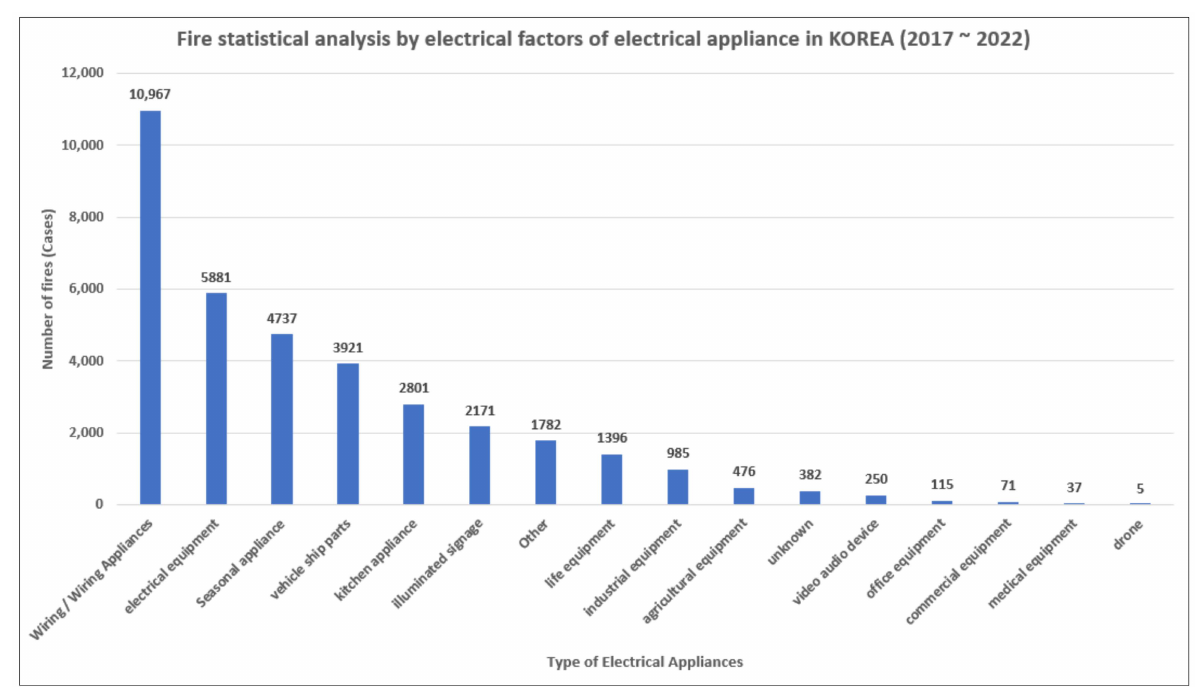
Figure 5. Fire statistical analysis by electrical factors of electrical appliances in ROK (2017–2022).